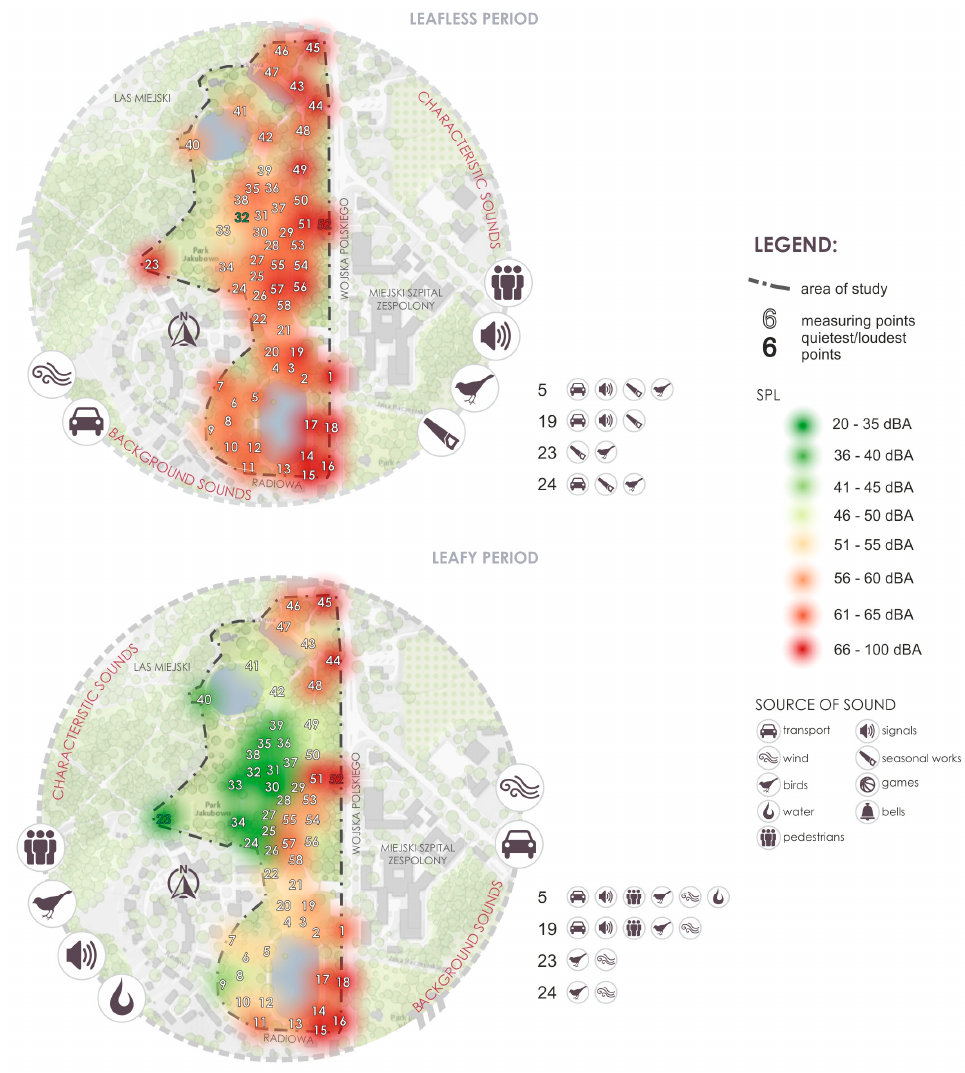
Figure 4. Acoustic map within boundaries of the Jakubowo park. Source: Own elaboration based on Acoustic Map of Olsztyn [93].